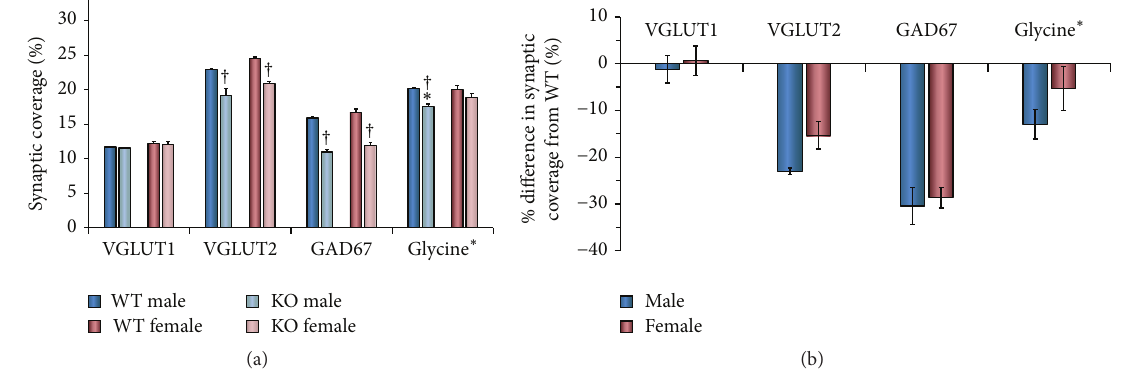
Figure 4: (a) The mean percent coverage ( ± SEM) by contacts immunoreactive to VGLUT1, VGLUT2, GAD67, or glycine in male and female tamoxifen treated SLICK::trkB f / f mice. These values were determined for each synapse-associated protein by averaging data from individual mice in the different groups. The significance of differences between groups was then evaluated with ANOVA. The estimated percent coverage by contacts containing glycine equals the percent coverage by VGAT+ contacts minus percent coverage by GAD67. WT refers to wildtype motoneurons without YFP that still retain trkB receptors. KO refers to knockout motoneurons labeled with YFP that do not have trkB receptors. † 𝑝 < 0.05 versus WT and ∗ 𝑝 < 0.05 versus female. (b) The same data are expressed as mean ( ± 95% confidence limits) percent differences between WT cells and KO